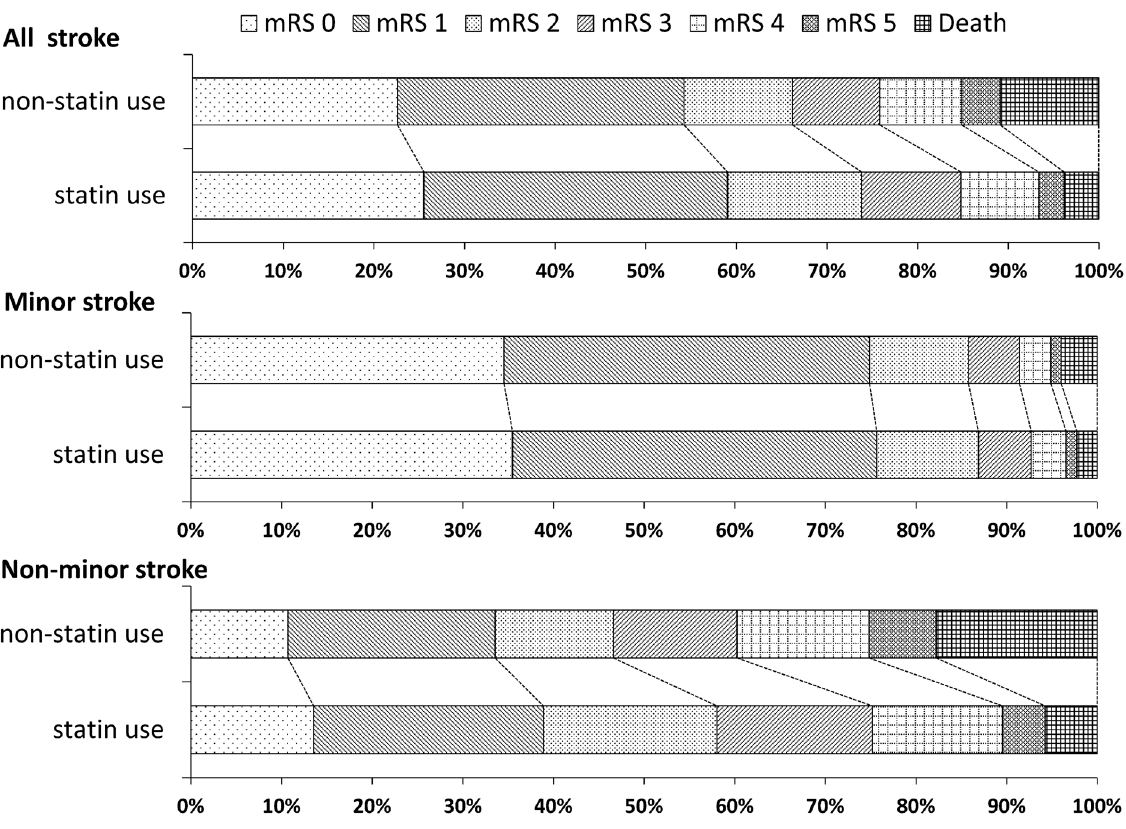
Figure 2. Percentage of mRS scores and death at 3 months for ischemic stroke patients stratified by statin use within hospitalization.